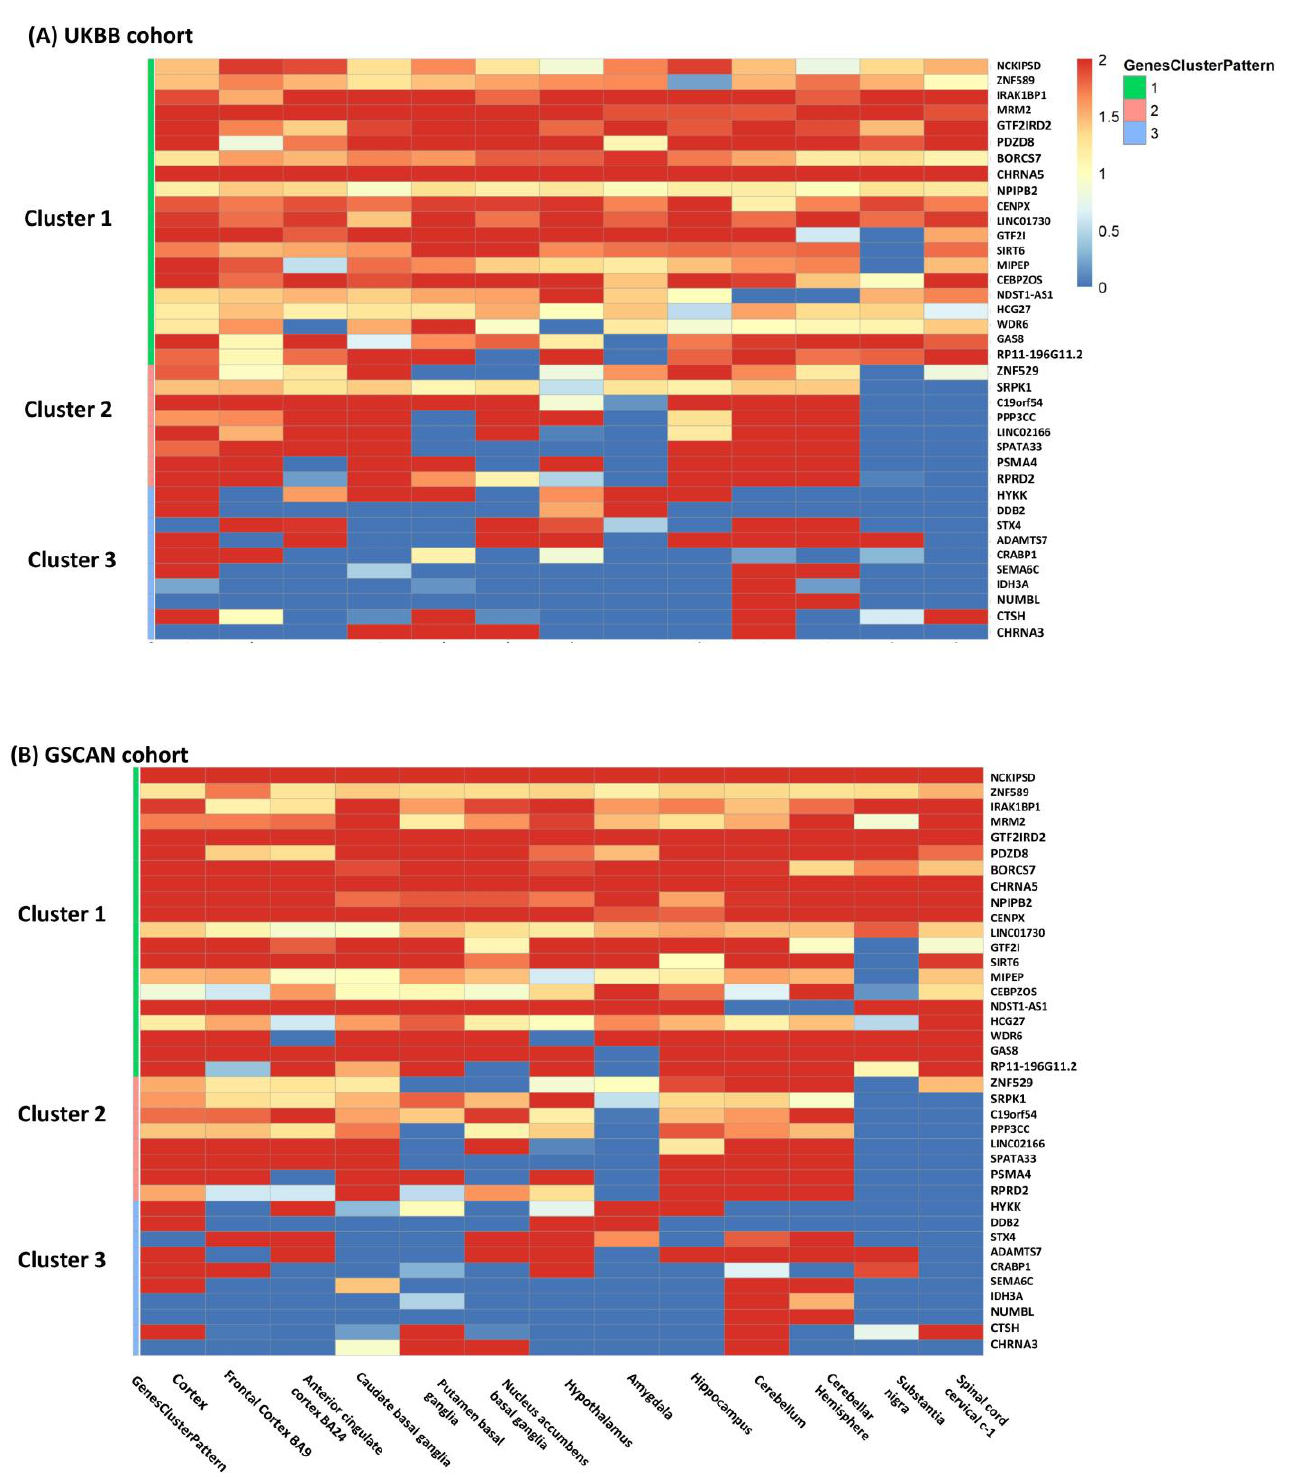
Figure 3. The heatmap included the 38 genes (Cluster 1: 20; Cluster 2: 8; Cluster 3: 10) with the same clustering patterns and passing meta-analysis FDR < 0.05 threshold in both cohorts and was colored by − log10( 𝑝 𝑔𝑠 ) of TS-TWAS in each brain tissue (on columns) from both cohorts (Panel ( A ) for UKBB and Panel ( B ) for GSCAN). In the rows, the genes were clustered into three categories common to two cohorts: cluster 1 was homogeneous genes, cluster 2 was partially homogeneous genes, and cluster 3 was tissue-specific or heterogeneous genes.